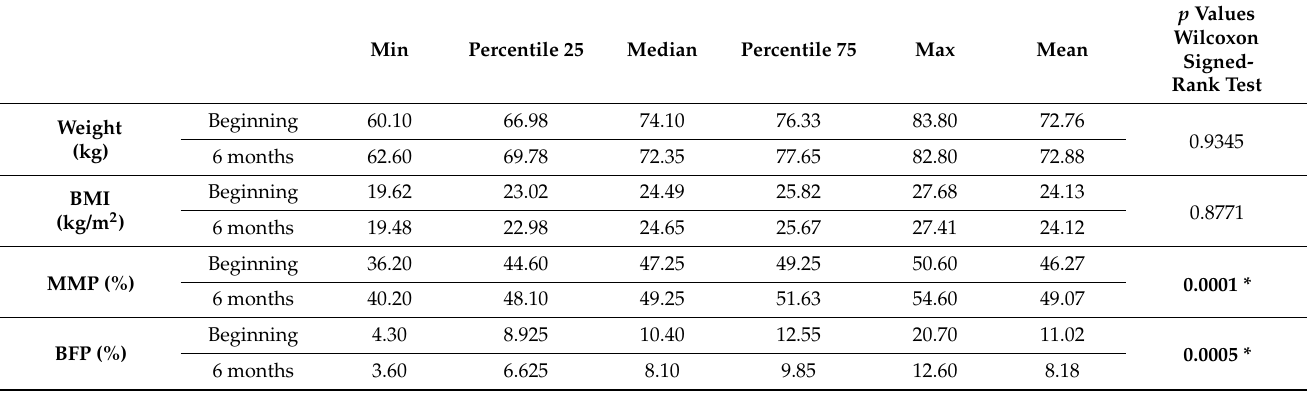
Table 2. Descriptive statistics of divers’ characteristics at the beginning and after 6 months of military training